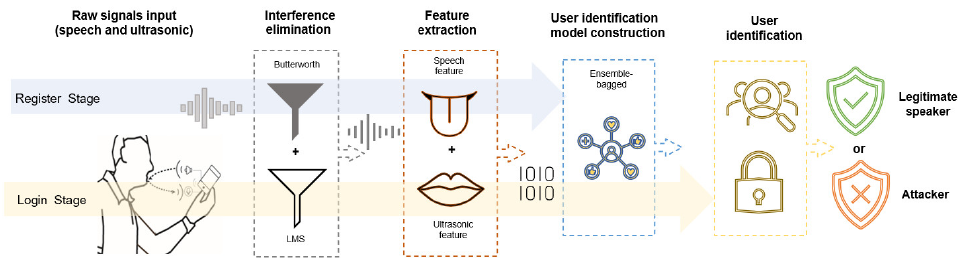
Figure 4. System framework of ArtiLock: (1) The interference elimination module removes the noise. (2) The speech feature extraction module extracts the oral articulation. (3) The ultrasonic feature extraction module envelopes mouth-reflected signals. (4) Authentication is performed by the user identification module using the training model.